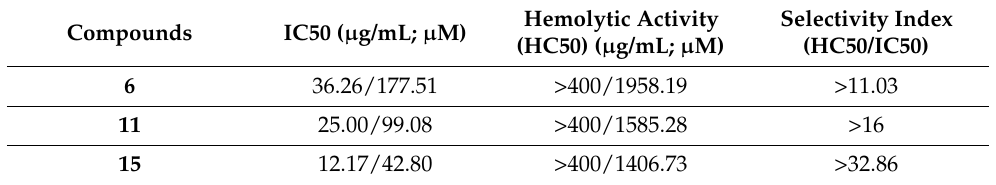
Table 2. Selectivity index and IC 50 of the compounds with the best antileishmanial